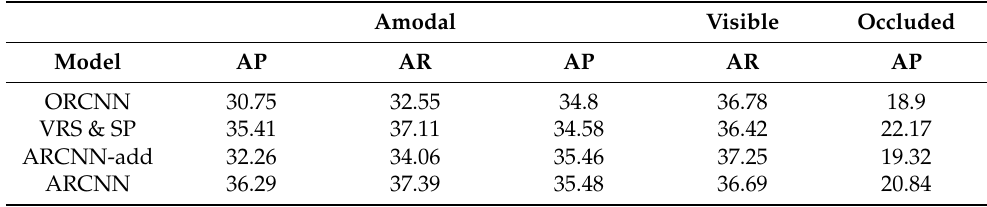
Table 2. The results on the COCOA cls dataset.